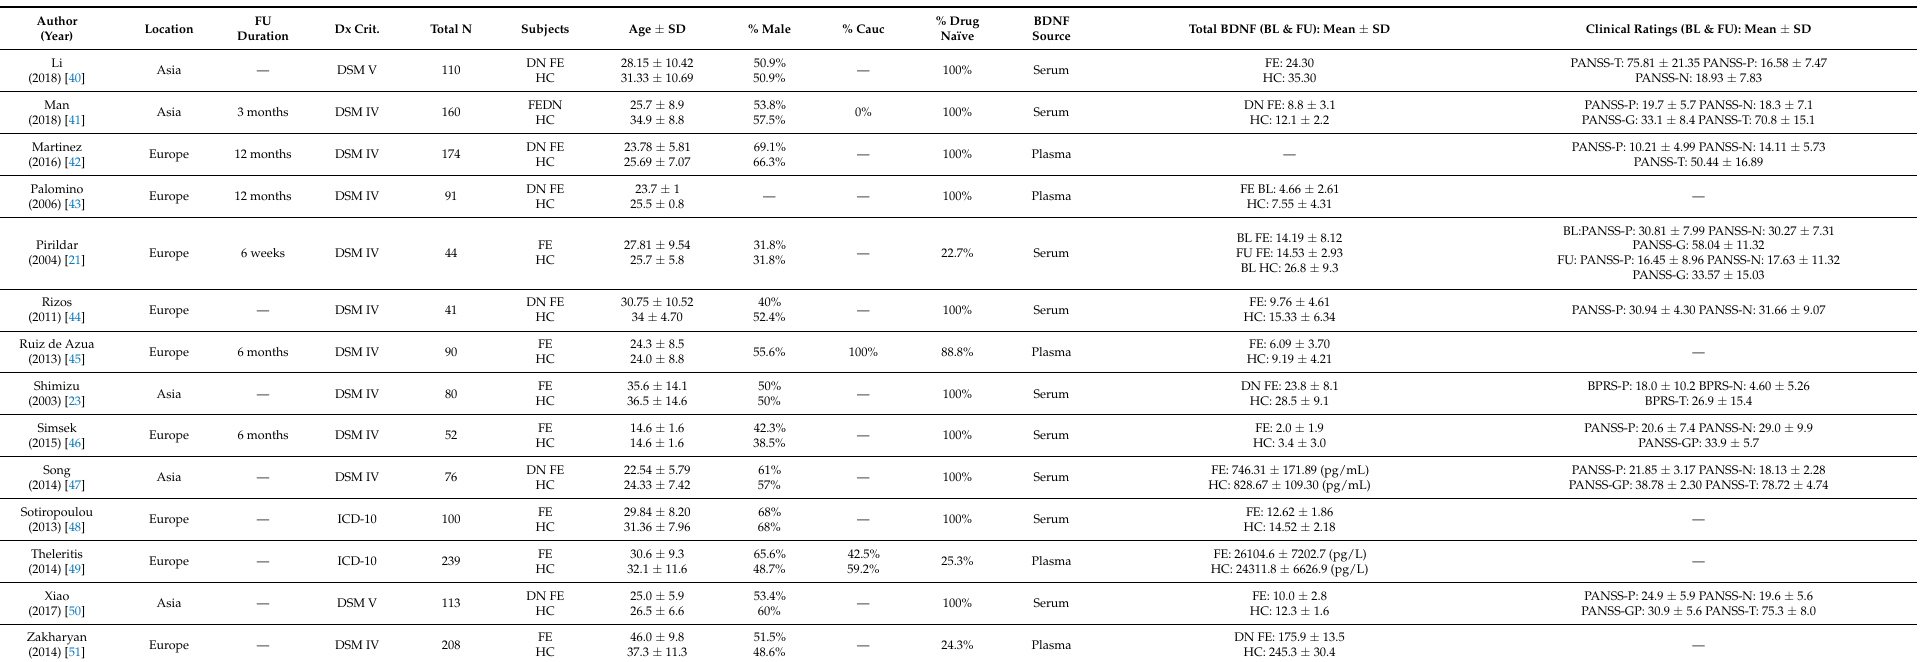
Abbreviations: DSM: Diagnostic and Statistical Manual of Mental Disorders; ICD: International Statistical Classification of Diseases and Related Health Problems; FE: First Episode, DN: Drug Naïve; HC: Healthy Control; BL: Baseline; FU: Follow up; Dx: Diagnosis; SD: Standard Deviation; Cauc: Caucasian, BDNF: Brain-Derived Neurotrophic Factor; PANSS-P: Positive and Negative Syndrome Scale-Positive; PANSS-N: Positive and Negative Syndrome Scale-Negative, PANSS-GP: Positive and Negative Syndrome Scale-General Psychopathology; PANSS-T: Positive and Negative Syndrome Scale-Total; BPRS-T: Brief Psychiatric Rating Scale-Total; BPRS-P: Brief Psychiatric Rating Scale-Positive; BPRS-N: Brief Psychiatric Rating Scale-Negative; SAPS: Scale for the Assessment of Positive Symptoms; SANS: Scale for the Assessment of Negative